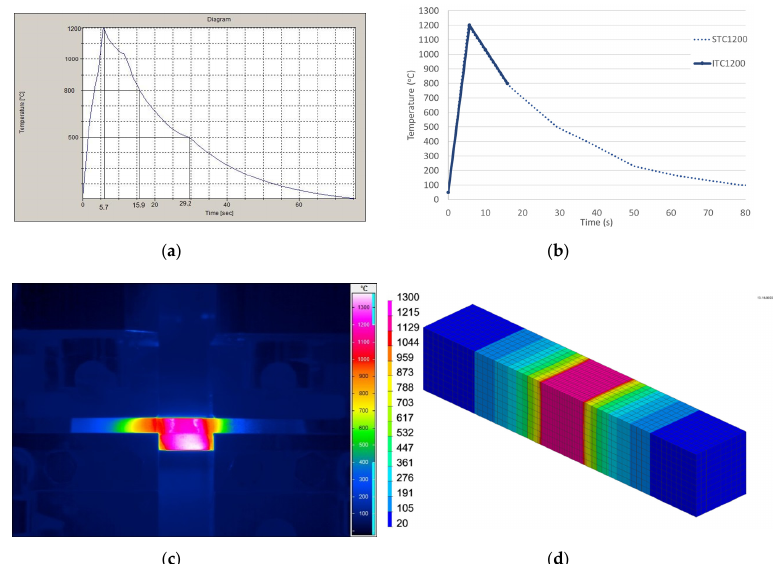
Figure 8. Comparison of ( a ) the registered and ( b ) the calculated thermal cycle as well as ( c ) the thermographic image and ( d ) the result of the numerical analysis in the form of temperature distribution for the thermal cycle with T max = 1200 °C.